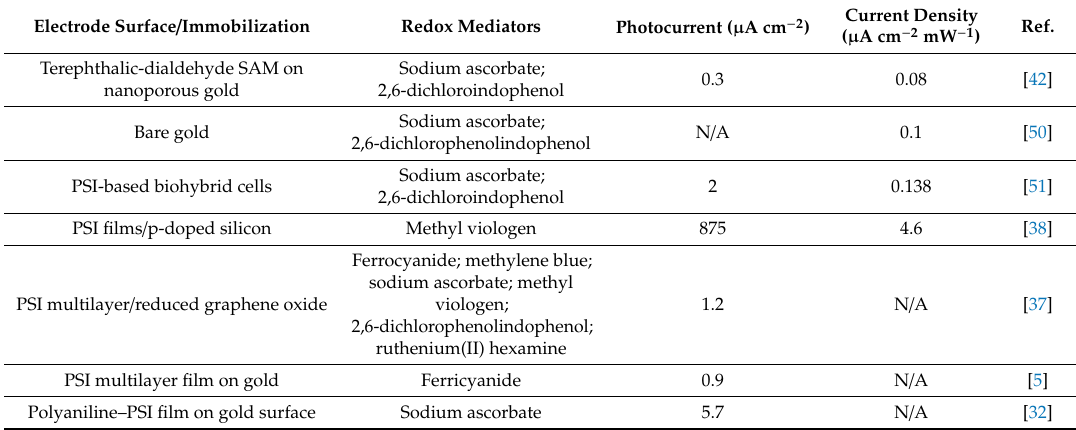
Table 1. Photocurrent Analysis of Higher Plant PSI-Based Biohybrid Devices †